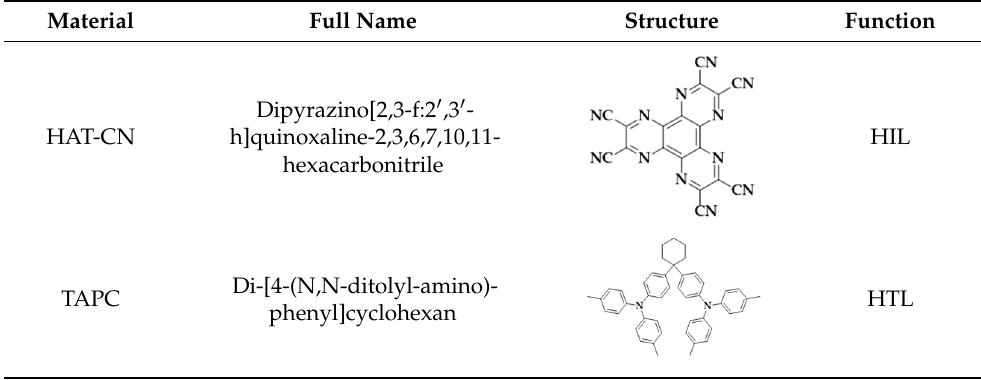
Table A1. Full name, molecular structure and function of auxiliary materials used in OLEDs in this review.